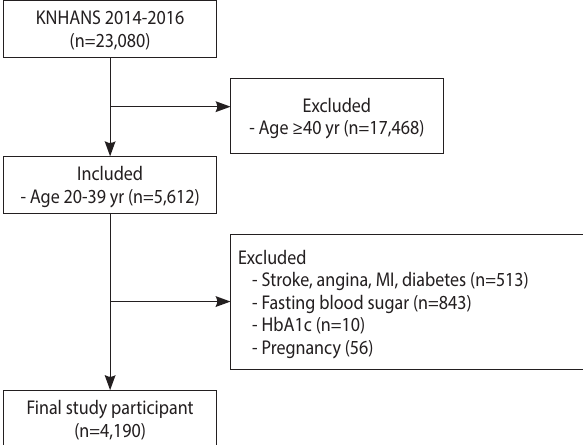
Figure 1. Flow chart of the study sample. KNHANES, Korea National Health and Nutrition Examination Survey; MI, myocardial infarction; HbA1c, hemoglobin